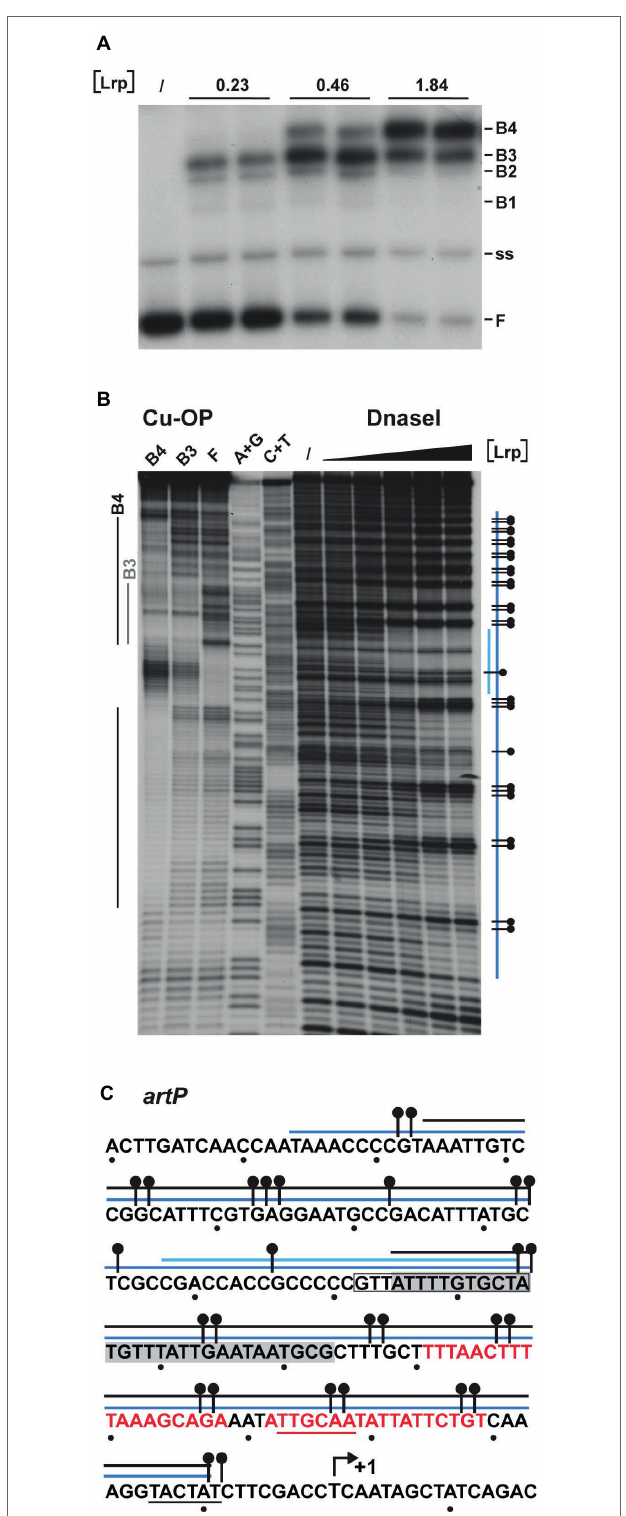
FIGURE 5 | DNAse I and in gel copper-phenanthroline (OP-Cu) footprinting of Lrp binding to the artP control region (top or coding strand revealed). (A) EMSA with Lrp binding to the artP control region used for the in